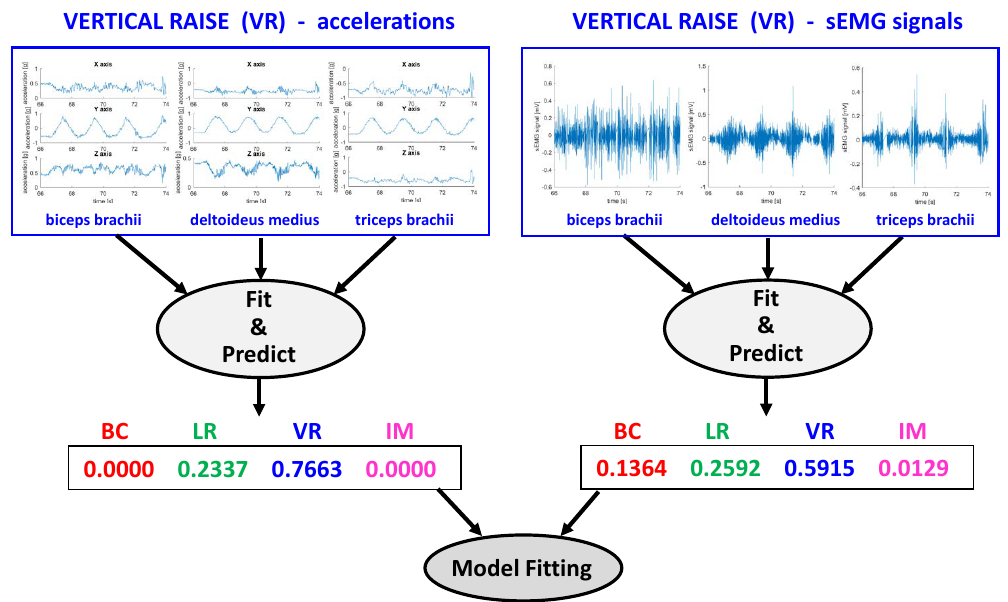
Figure 7. Example of the processing of a single signal frame through the training stage: time-domain signals (top) are used to train classification models, after feature extraction (not shown). Scores from these classification models are then fused together and used to train the final